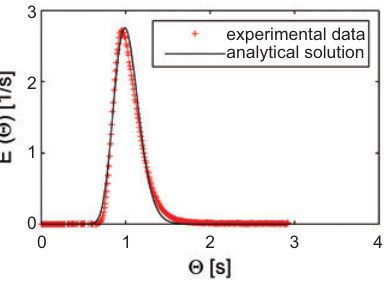
Figure 9 Analytical solution of the boundary condition for open- open systems at given Bodenstein numbers to fit the experimental data for a residence time of 116 s at a Reynolds number of 11.